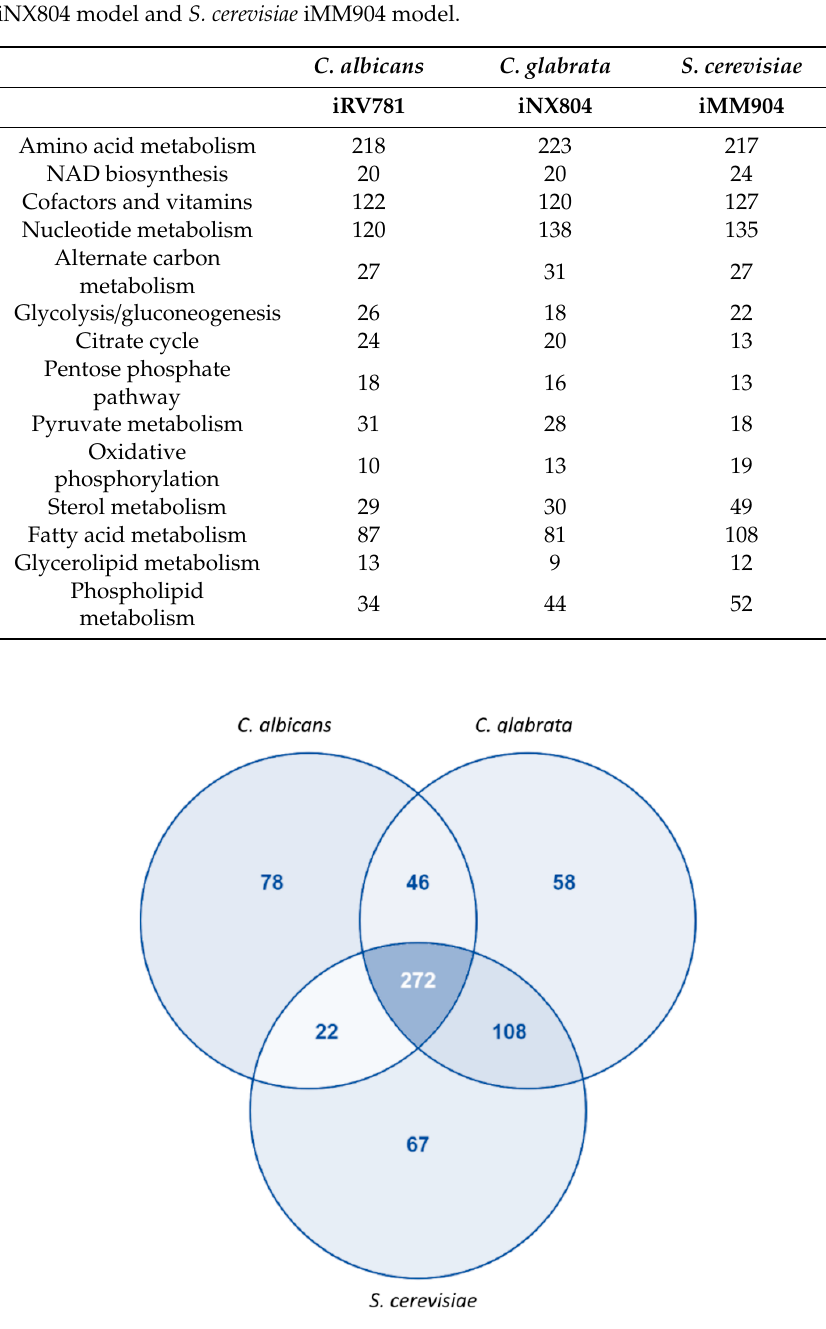
Figure 2. Comparison between C. albicans , S. cerevisiae and C. glabrata proteins with associated EC Numbers present in the genome-scale metabolic models iRV781, iIN800, and iNX804, respectively. Diagram obtained using VENNY2.1 tool [43].